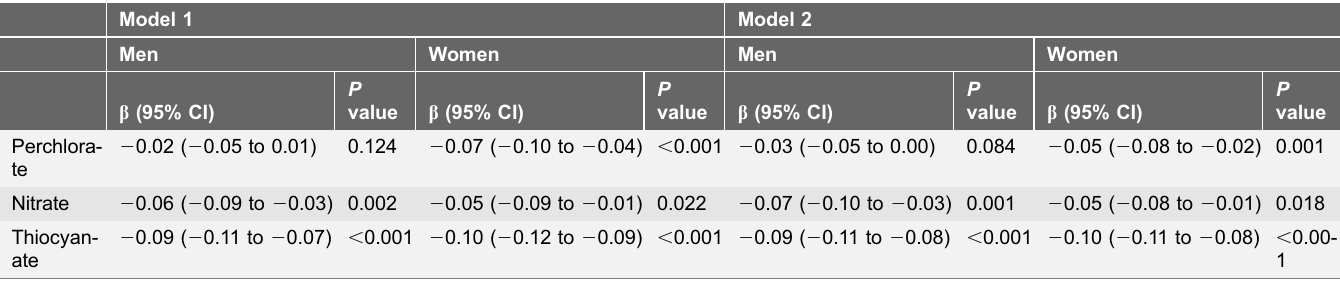
Table 2. Adjusted regression coefficients with 95% confidence intervals (95% CIs) by multiple linear regression analysis for serum parathyroid hormone levels and creatinine-corrected urinary concentrations of perchlorate, nitrate, and thiocyanate among the United States adults, NHANES 2005–2006. Model